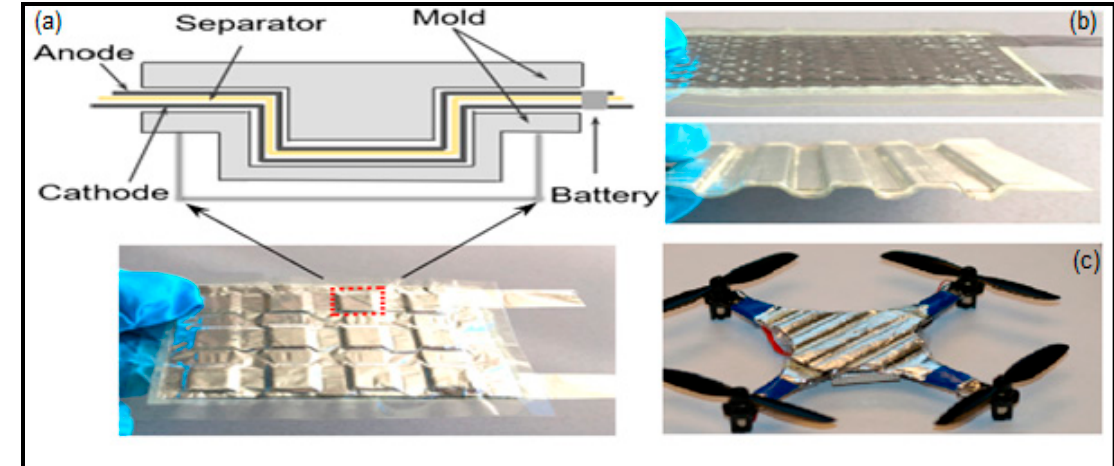
Figure 16. ( a ) Schematic of the mold used for plastic deformation studies. ( b ) Different